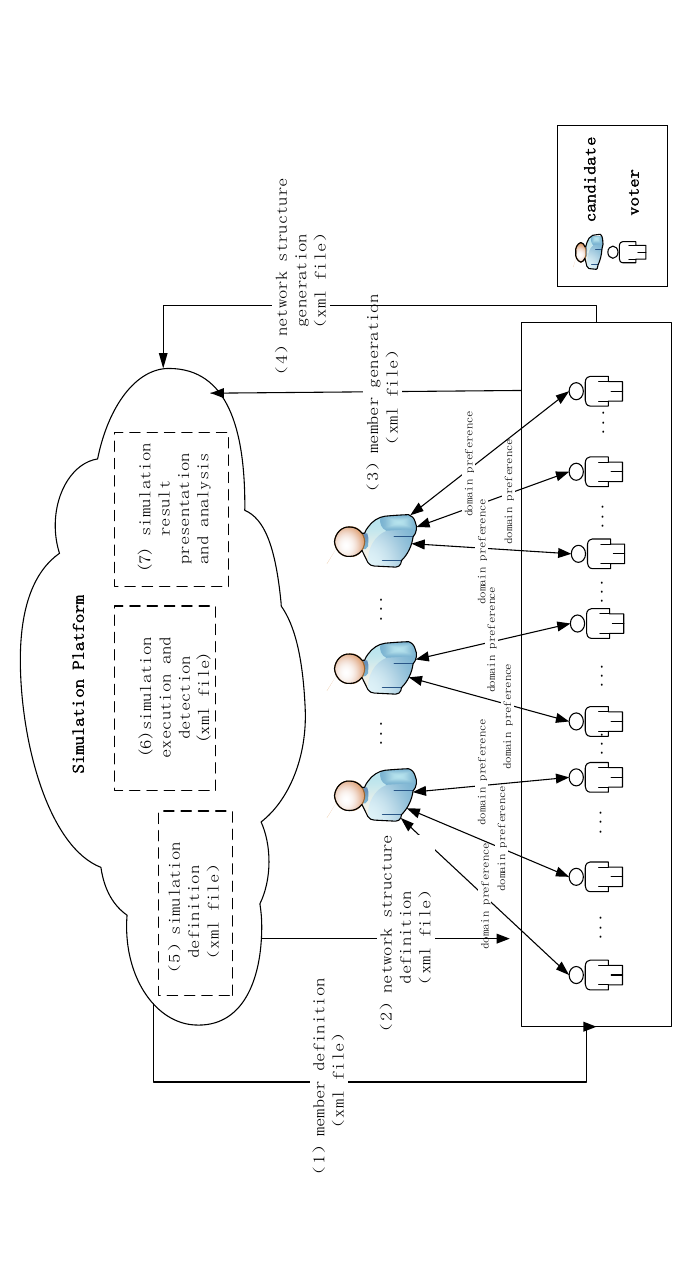
Figure 4. The conceptual of Crowed